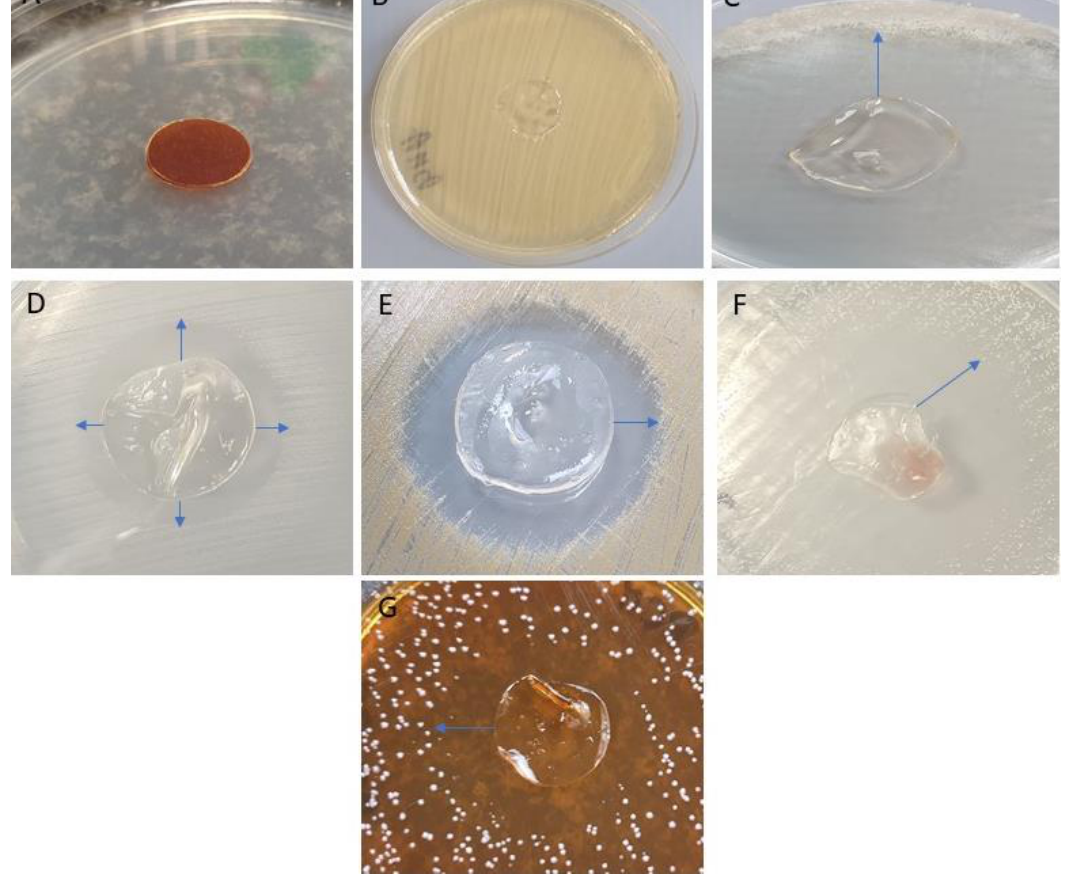
Figure 6. Antimicrobial activity of PVA/HPMC_B film with incorporated PVP-I. ( A ) The film placed on the sterile agar plate surface; ( B ) control representative setting: film without PVP-I placed on the S. aureus lawn displays no antimicrobial activity (no inhibition zone is observed); ( C ) inhibition zone of C. albicans growth; ( D ) inhibition zone of E. faecalis growth; ( E ) inhibition zone of S. aureus growth; ( F ) inhibition zone of P. aeruginosa growth; ( G ) inhibition zone of L. rhamnosus aeruginosa growth. Arrows indicate the size of inhibition zones. Note the discoloration of the dressing in panels ( C – G ), which occurred as a result of PVP-I release, compared to panel ( A ). Also note the folding of the film in panels ( C – G ), which was a result of drying during the incubation period, compared to ( A